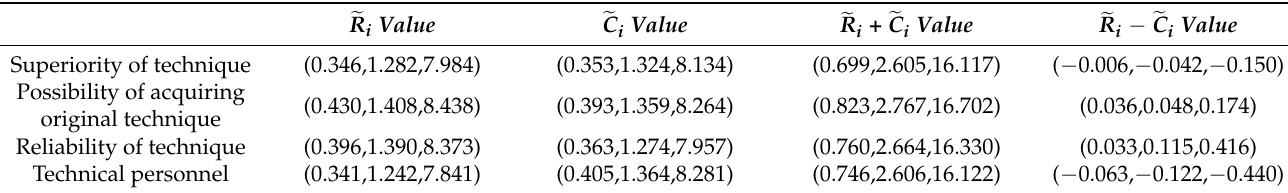
 R value ,  C value ,   i i i